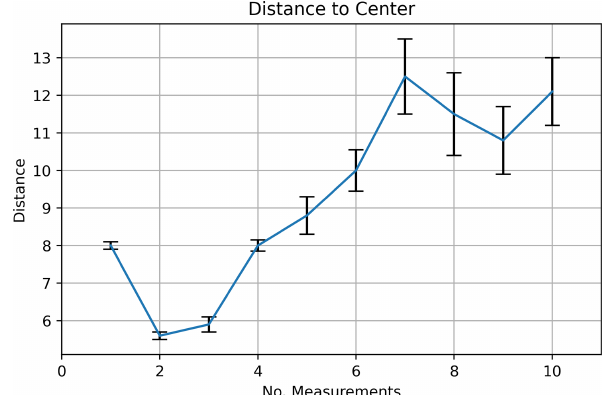
Figure 24. Measurement distance to center, POMCPOW without action constraints, single body with variable location. The plot shows the average distance between the measurement location and the mineralization center for the measurements at each time step. 1 standard error bars are also